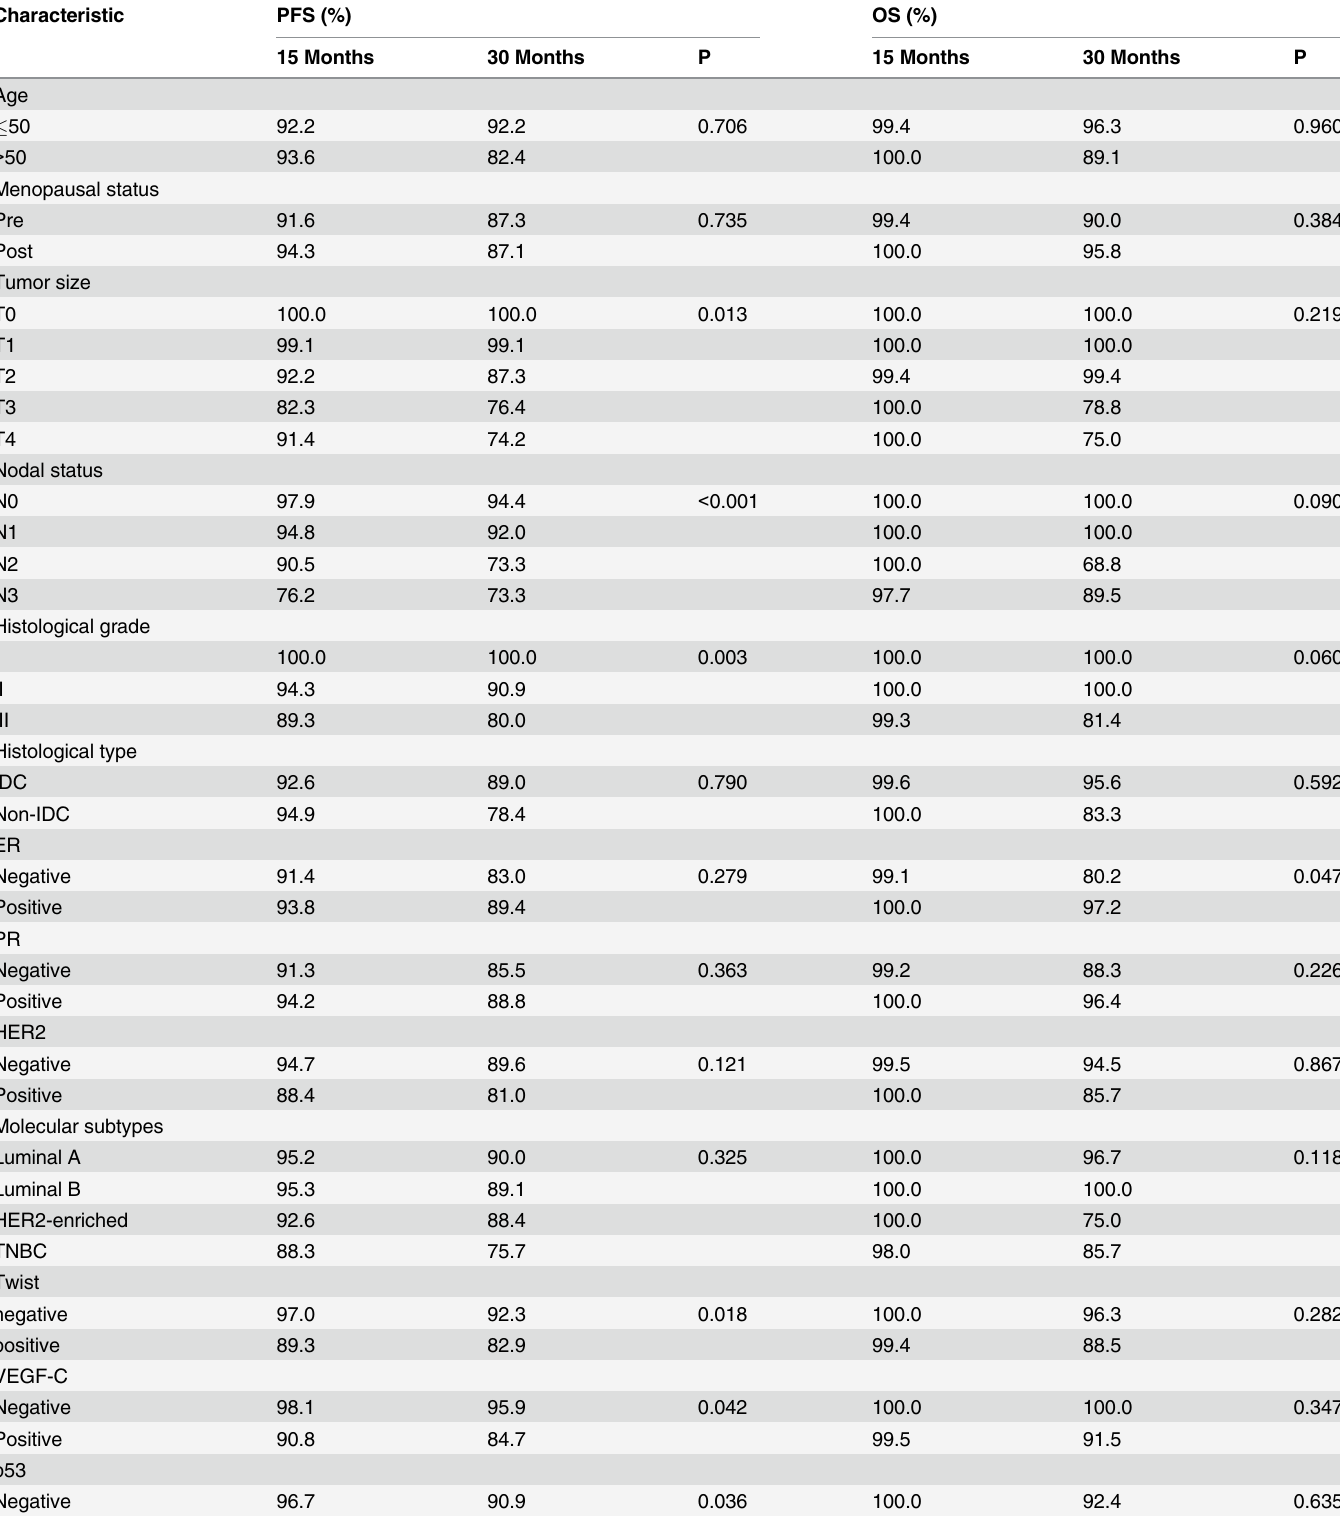
Table 4. Kaplan-Meier analysis for prediction of PFS and